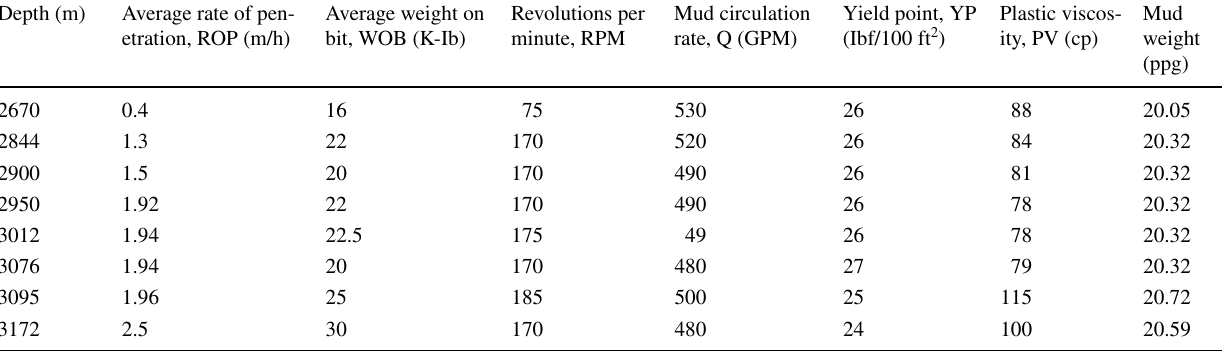
Table 4 Drilling and mud data corresponding to Gachsaran formation (in Kupal field) at some main depths Depth